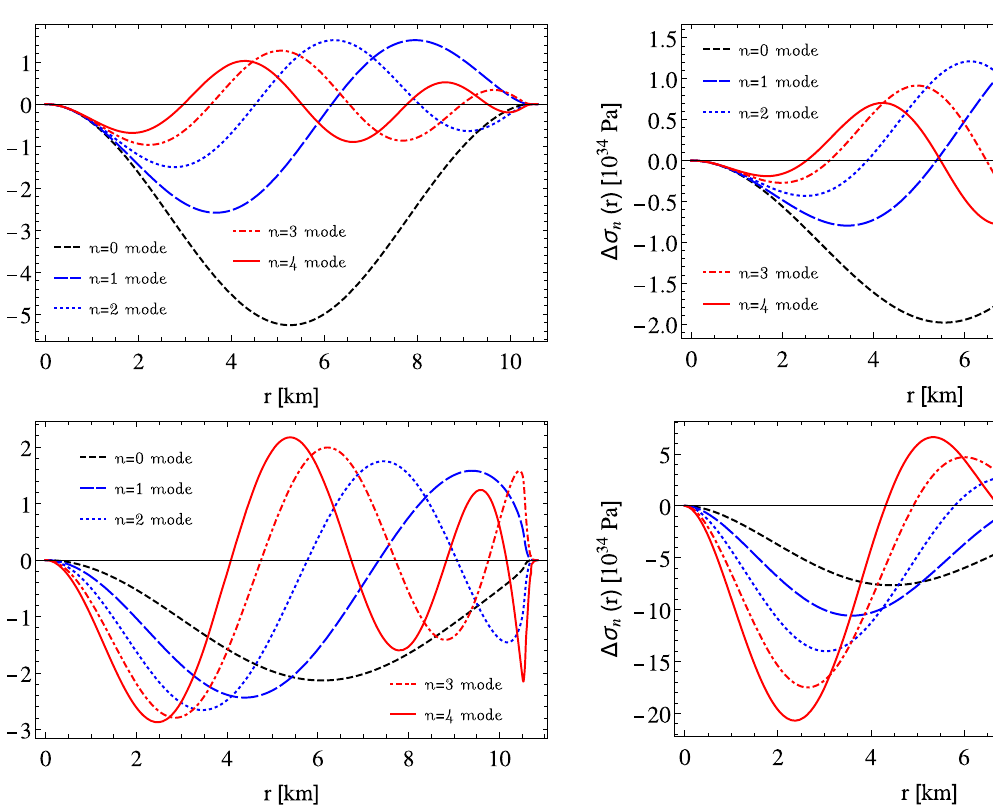
Fig. 3 Lagrangianperturbationoftheanisotropyfactorforthefirstfive normal oscillation modes as a function of the radial coordinate obtained for a central mass density ρ c = 2 . 0 × 10 18 kg / m 3 with SLy EoS (29). The upper left, upper right, lower left and lower right panels correspond